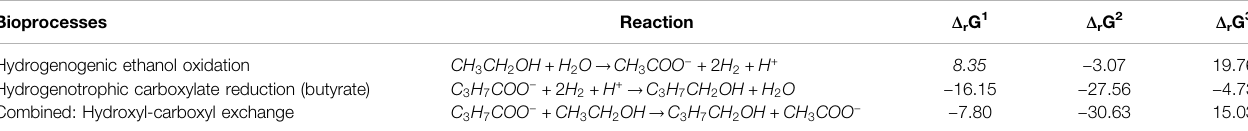
TABLE 6 | Thermodynamic calculations for ethanol oxidation and carboxylate (n-butyrate as example) reduction towards the corresponding alcohol (n-butanol). Δ r G 1 indicates the reaction Gibbs free energy change at standard biological conditions (298 ° C, pH 7). Δ r G 2 and Δ r G 3 are corrected for reactants to products ratios (carboxylates and alcohols only) of 100 and 0.01, respectively.